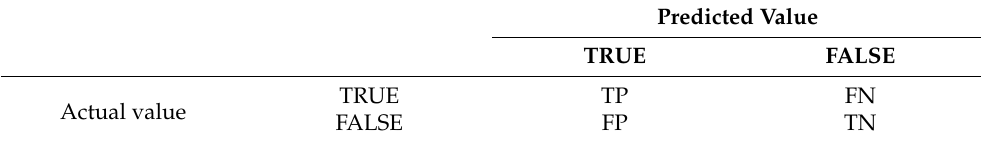
Table 4. Confusion matrix.